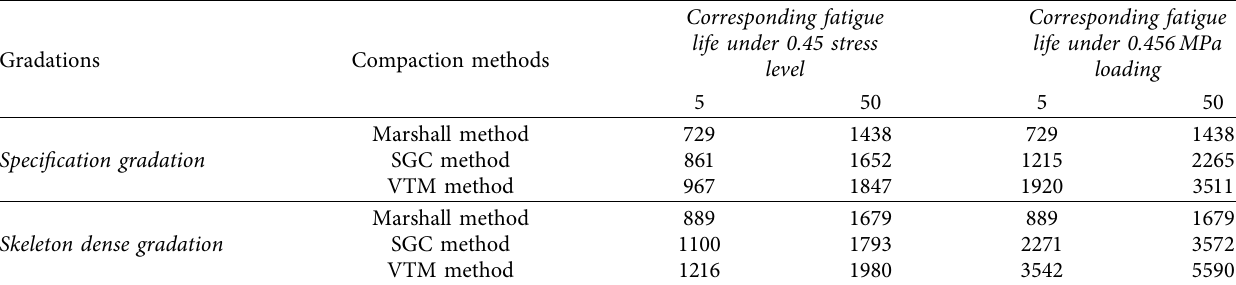
Table 14: Fatigue life of SMA-13 mixture with different compaction methods and gradations.